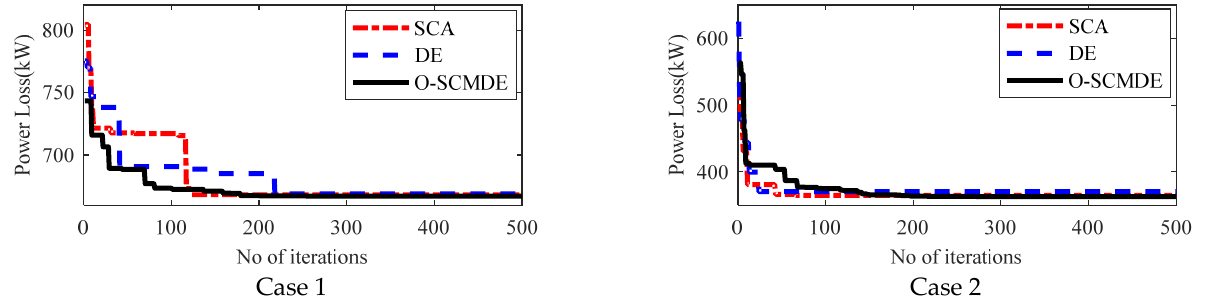
Figure 8. Comparison of the convergence characteristics of the SCA, DEA and O-SCMDEA for both cases of scenario I of the 118 bus